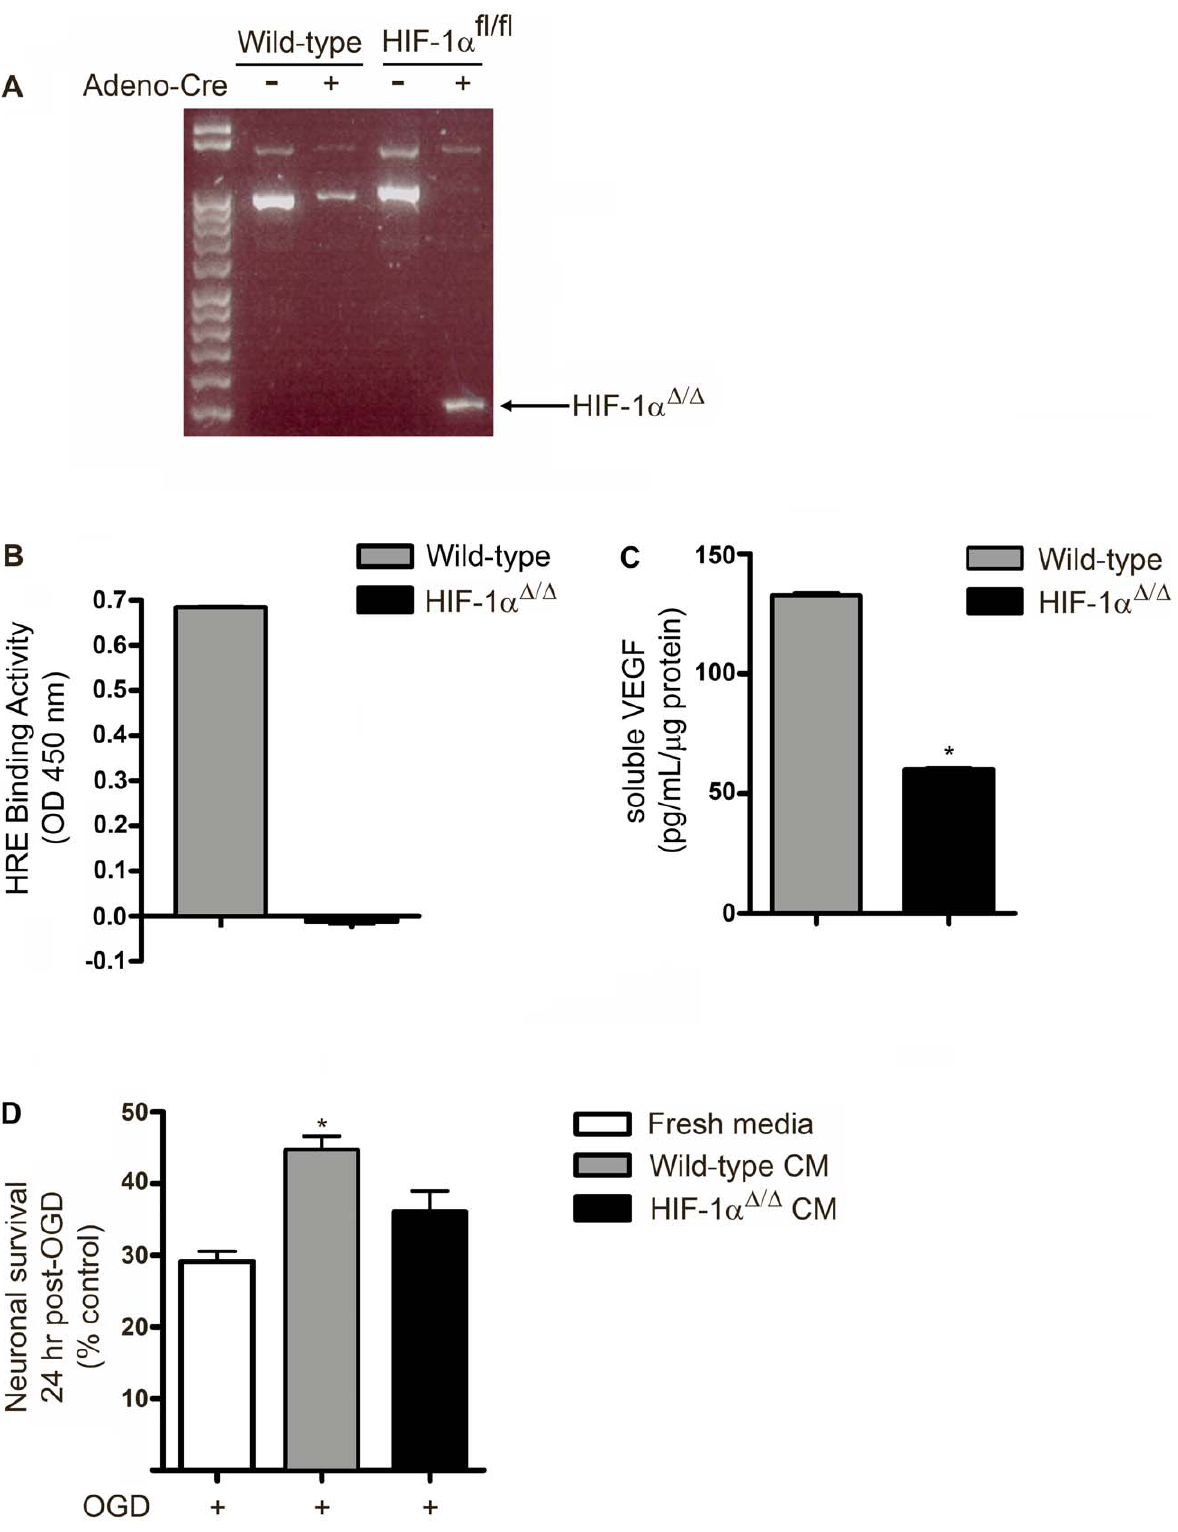
Figure 5. Gene deletion of HIF-1 a impairs neuroprotective ability of eNSPC. ( A ) PCR amplification products from genomic DNA isolated from wild-type and HIF-1 a fl/fl NSPCs exposed to 50 MOI Ad-CMV-Cre for 48 hrs. Excision of exon 2 from HIF-1 a gene is indicated by the shorter band at 250 bp, present after Ad-CMV-Cre exposure of HIF-1 a fl/fl but not wild-type NSPCs. ( B ) Transcriptional activity of HIF-1 a in wild-type vs. HIF-1 a D / D NSPCs assayed by HRE binding assay. ( C ) VEGF in 24 hr conditioned media from wild-type vs. HIF-1 a D / D NSPCs. ( D ) Viability of cortical cultures 24 hr following 2 hr OGD in the presence or absence of wild-type vs. HIF-1 a D / D NSPCs CM. *p , 0.05, n= 4 cultures/group.